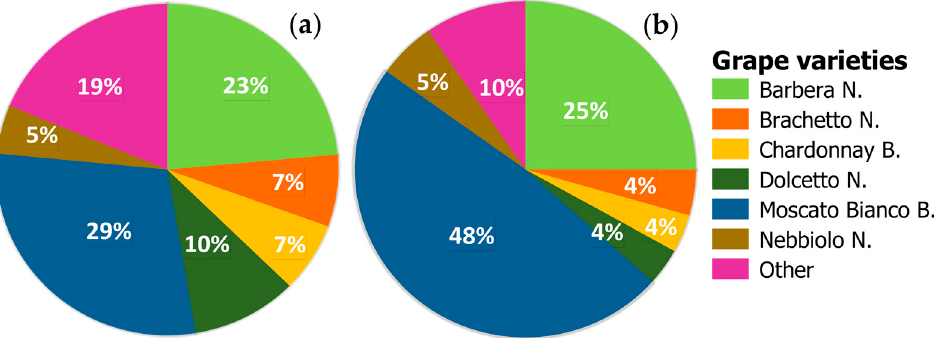
Figure 3. Percentage distribution of grape varieties in AOI: ( a ) number of parcels (%) of the main grapevine varieties (total parcels = 17,442); and ( b ) area size (%) of the main grapevine varieties (total area = about 23,490 ha).